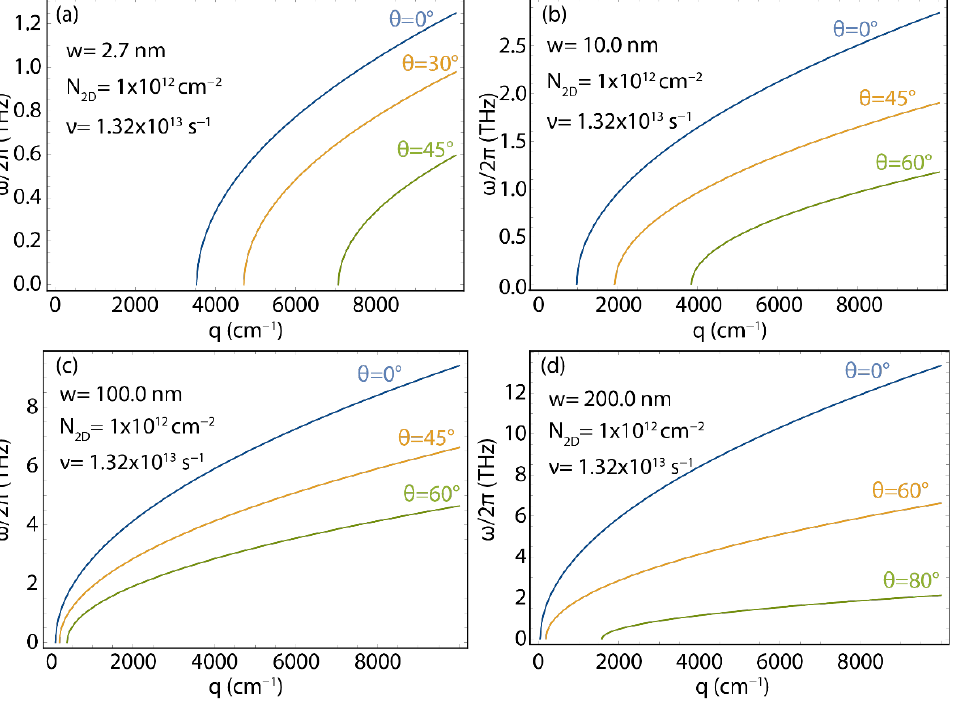
Figure 8. Plasmon energy ( ω /2 π ) vs. wave vector ( q ), as obtained using Equation (5) (with v F = 0.829 × 10 6 m/s, ν = 1.32 × 10 13 s − 1 , and N 2 D = 1 × 10 12 cm − 2 ) for different orientations of the plasmon momentum ( θ ) , in GNRs array with different ribbon widths: w = 2.7 nm ( a ), w = 10 nm ( b ), w = 100 nm ( c ), and w = 200 nm ( d ). The corresponding effective masses ( m ∗ ) are reported in Table